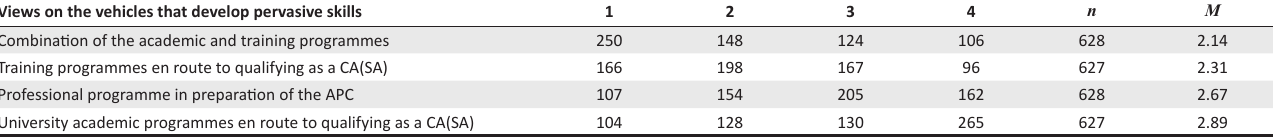
TABLE 3: Aspirant chartered accountants’ views on the vehicles that most effectively develop pervasive skills. Views on the vehicles that develop pervasive skills